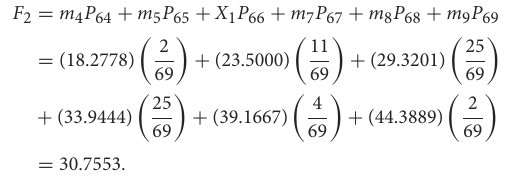
TABLE 6 Comparison of AIC and BIC values ARFIMA ( p , d , q ) model with d =